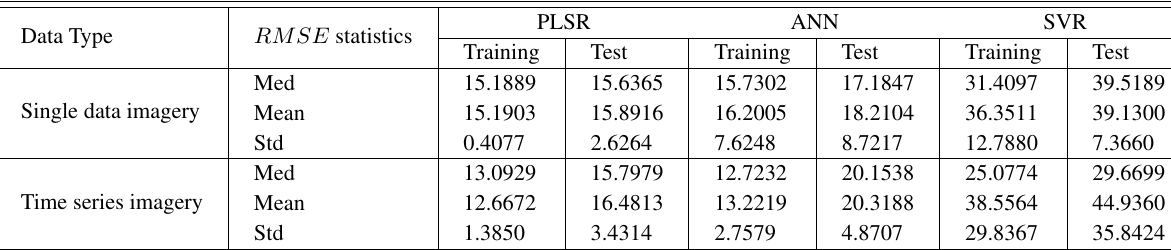
Table 2. Statistics of root mean square error